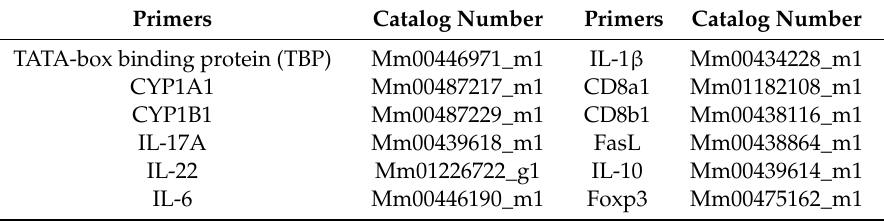
Table 1. The list of PCR primers used in this